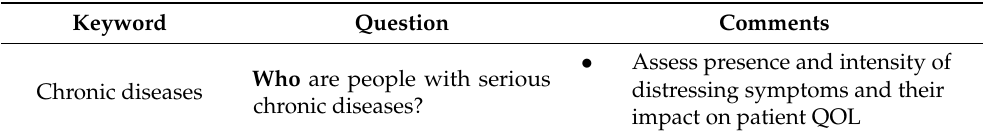
Table 1. A brief summary of the questions to be addressed to identify a model for delivering the best care to the palliative care